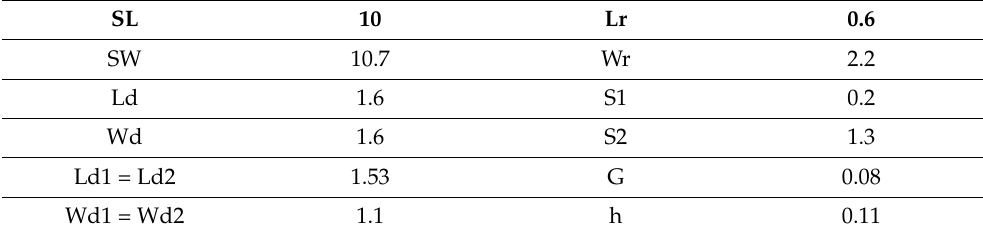
Table 1. Description of elements for designing antenna in